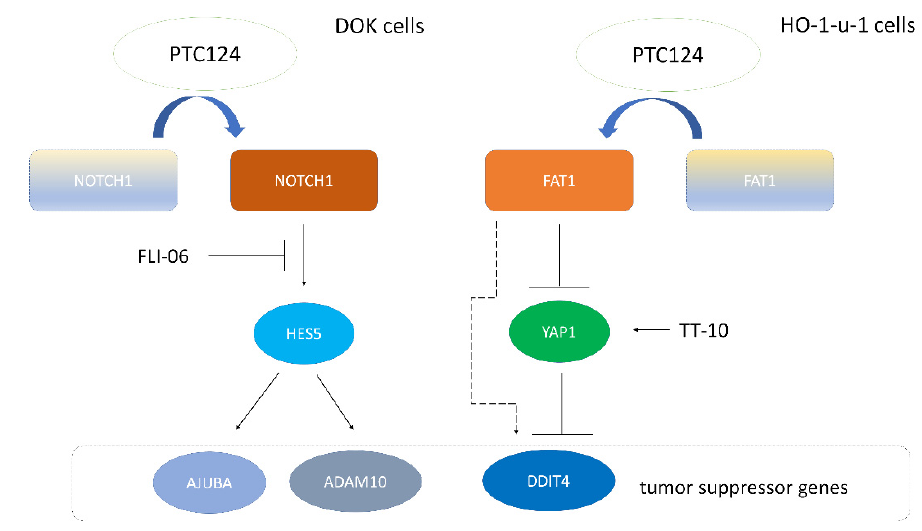
Figure 6. PTC124 can rescue nonsense mutation of two tumor suppressor genes NOTCH1 and FAT1 to repress HNSCC cell proliferation. PTC124 can induce the expression of NOTCH1 (left blue arrow) and NOTCH1 downstream genes ( HES5 , AJUBA , and ADAM10 ) in DOK cells (with NOTCH1 Y550X). FLI-06 is a NOTCH signaling inhibitor. FLI-06 can reverse PTC124-mediated cell growth inhibition in DOK cells. PTC124 can induce FAT1 (right blue arrow) and DDIT4 (dash line arrow) expression in HO-1-u-1 cells (with FAT1 E378X). TT-10 is a YAP signaling activator. PTC124 can reverse TT-10-mediated HO-1-u-1 cell proliferation.